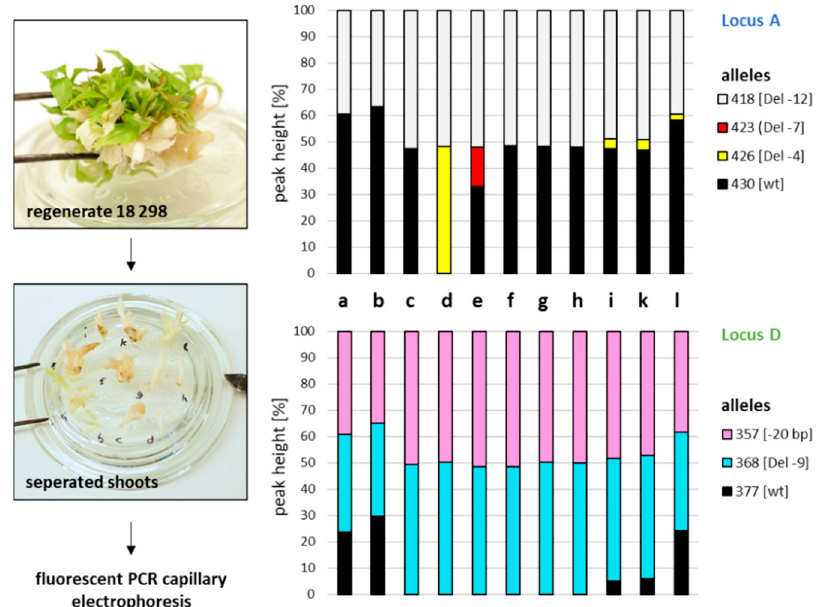
Figure 5. Distribution of CRISPR/ Lb Cas12a induced GE events in a chimeric regenerate. Different albino shoots originating from tissue transformed with the CRISPR/LbCas12a construct were separated and genotyped by fluorescent PCR capillary gel electrophoresis. The percentages of the total peak heights of each allele detected for locus A (upper panel) and locus D (lower panel) are represented in the